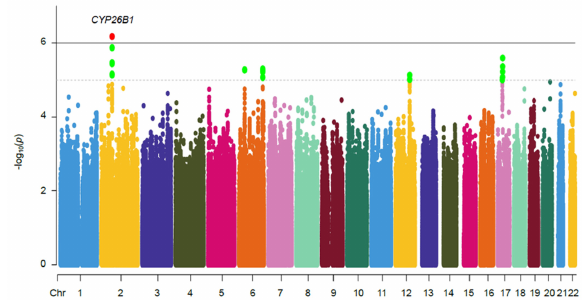
Figure 2. Manhattan plot for hand OA association in Han Chinese population. Manhattan plot of the genome-wide association study of 420 subjects with hand OA and 716 unaffected controls. The x axis is each of the SNPs in the initial scan, and the y axis is the -log 10 p -value of the Cochran-Armitage trend test. Horizontal dashed lines indicate − log 10 ( p ) = 5 , whereas solid black lines indicate − log 10 ( p ) = 6.